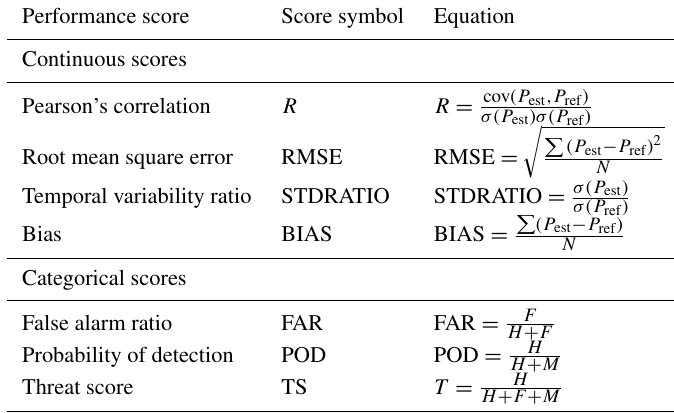
Table A1. Equations used for the performance scores. For the continuous scores, P ref is the reference dataset (e.g. ground observations, ERA5), P est is the estimated dataset (e.g. SM2RAIN–ASCAT, GPM-ER), cov is the covariance operator, σ is the standard deviation operator, P is the summation operator, and N is the sample size. For the categorical scores, H is the number of successfully predicted events by a given rainfall product, F the number of non-events erroneously predicted to occur, and M is the number of actual events that are